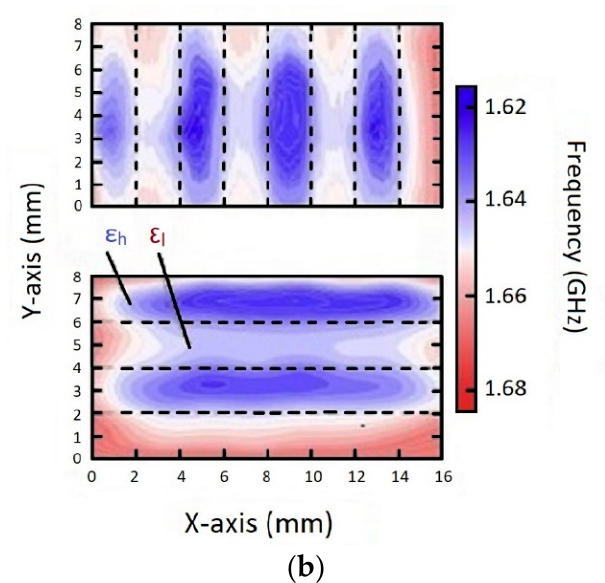
Figure 5. ( a ) Various printed coupons for dielectric characterization, comprising stripes or other arrangements of relatively low (ABS only) and high (dielectric ceramic/ABS composite) permittivity materials; ( b ) Experimental measurements of the directional resonant frequencies distribution of the split ring probe (Reprinted from Ref. [57], copyright (2016), with the kind permission of Elsevier). The test results for dielectric properties for various materials are presented in Table 2.